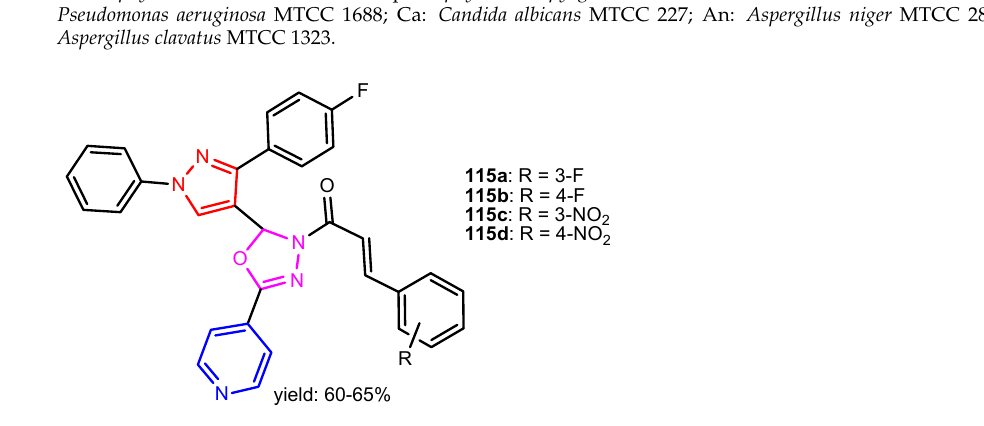
Figure 11. Pyridyl-pyrazole-1,3,4-oxadiazoles 115a − 115d [53]. 5. Synthesis of Antimicrobial Pyridine Compounds Containing a Five-Membered Ring with Three Heteroatoms